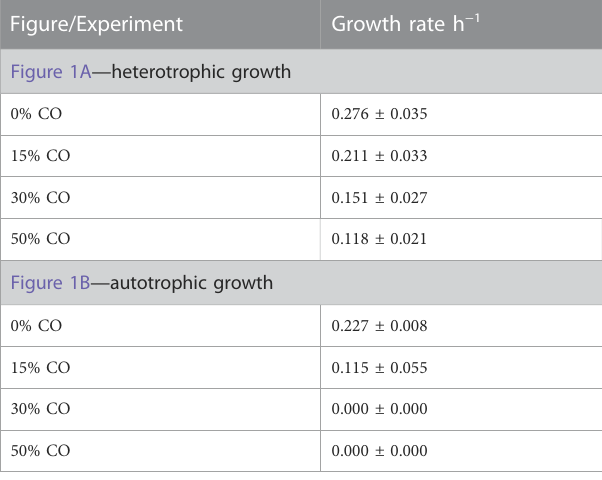
TABLE 1 Growth rates for C. necator H16 with increasing CO concentrations. Figure/Experiment Growth rate h − 1 Figure 1A — heterotrophic growth